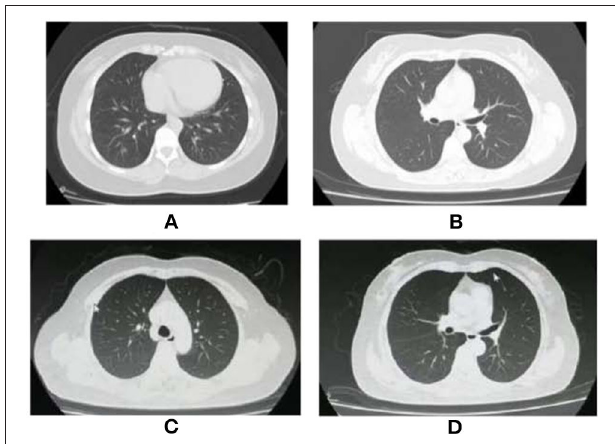
FIGURE 1 | Chest CT images of two cases with COVID-19. (A) The Chest CT images of the Case 1 showed ground-glass opacities in basal segment of the lower lobe of the right lung on January 2. (B) The Chest CT images of the Case 1 showed almost normal on March 23. (C) The Chest CT images of